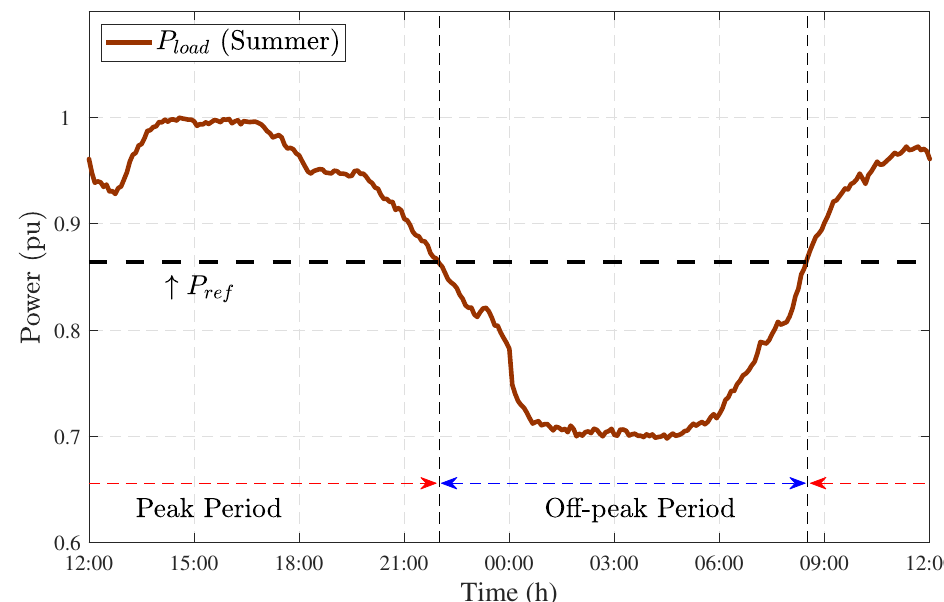
Figure 1. Load profile trend of Republic of Korea for a summer